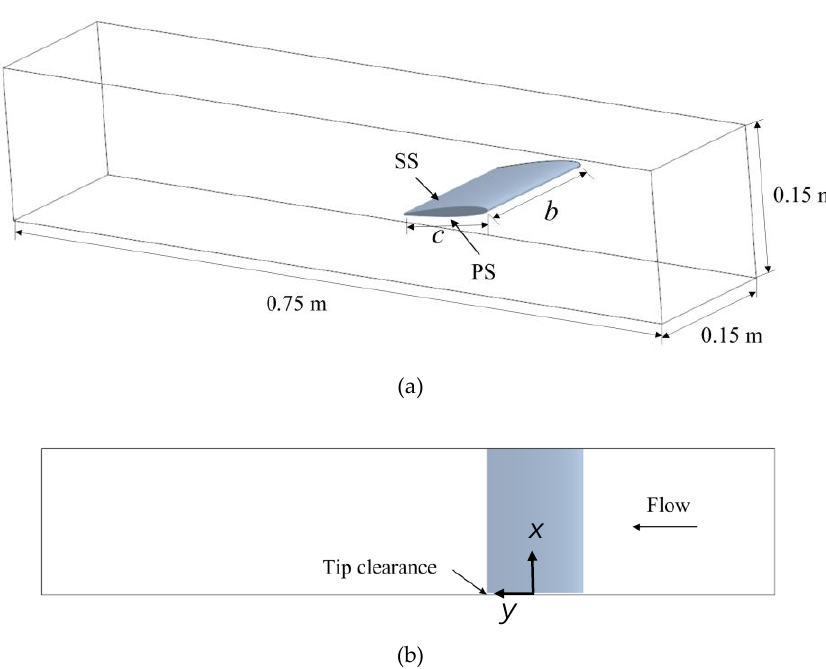
Figure 1. Physical model of NACA0009 hydrofoil. ( a ) Isometric view. ( b ) The gap.